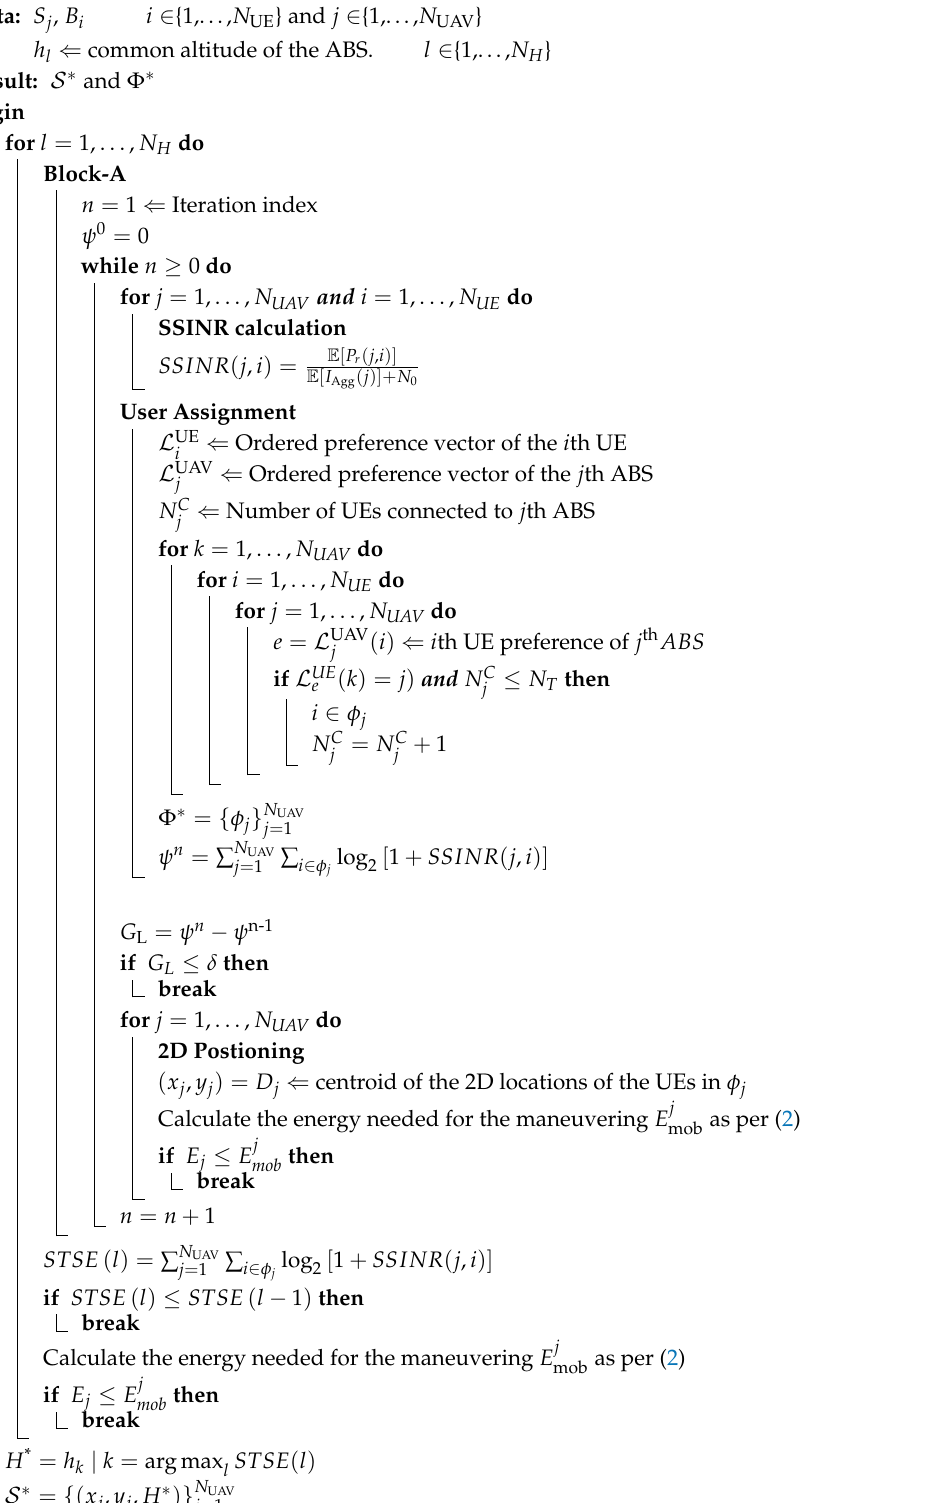
Algorithm 1: Clustering and matching algorithm with exhaustive